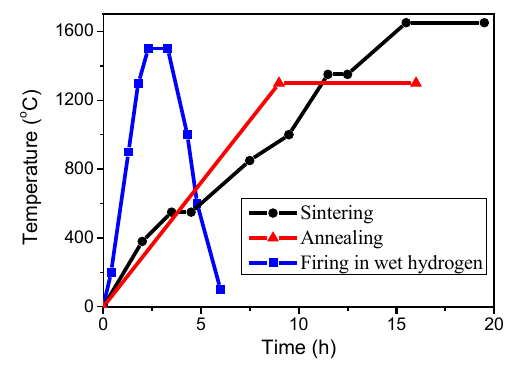
Fig. 1 Sintering temperature curve, the annealing temperature curve, and the temperature curve of firing in wet